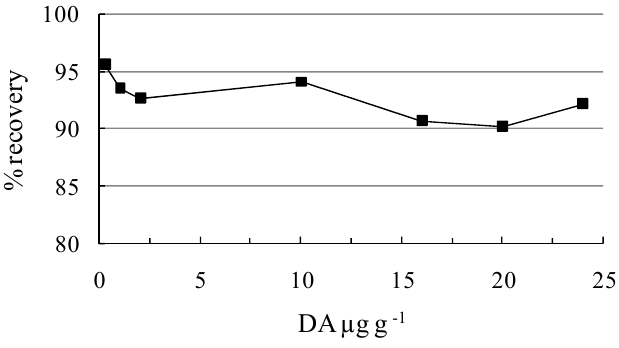
Figure 8. Recovery of DA in mussel tissues spiked at different levels using sax clean-up, n = 5.